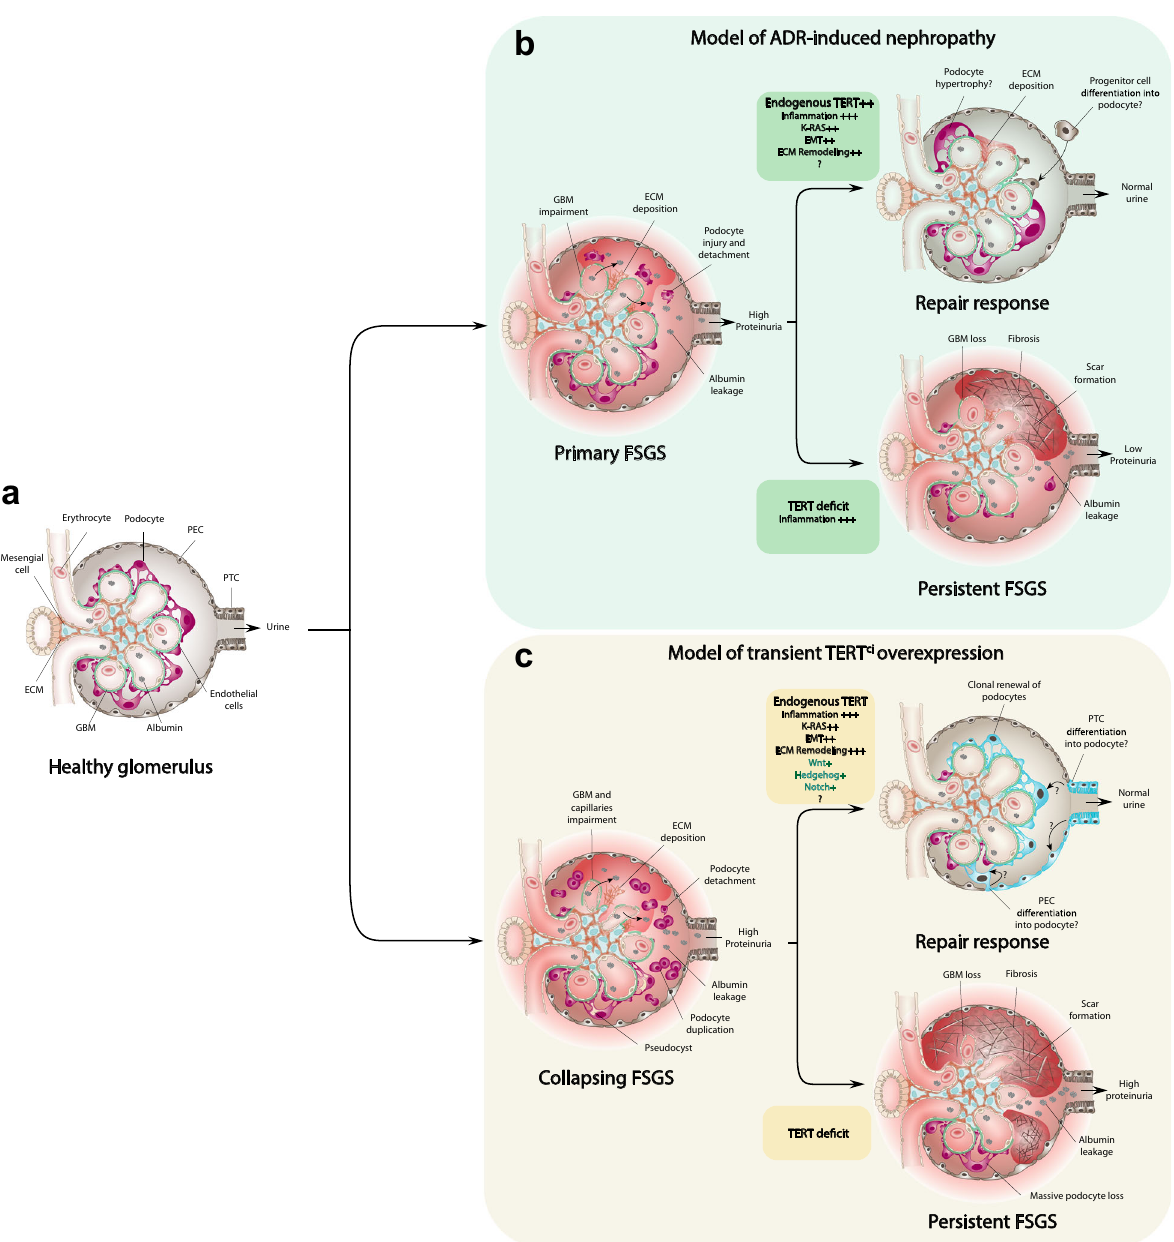
Fig. 8 TERT exhibits non-canonical functions in glomerular repair and podocyte renewal in the adult mouse kidney. Model to illustrate the non-canonical functions of endogenous TERT and TERT ci pulse in glomerular regeneration. a Healthy glomerulus showing terminally differentiated podocytes and intact glomerular basement membrane (GBM). b Following ADR-induced injury, podocytes insult conducts to their detachment from the glomerular capillaries and destabilization of the GBM. Albumin leakage in the urine leads to an increase of proteinuria. Two physiological responses can occur, a repair response that may involve putative podocyte hypertrophy and/or progenitor cell differentiation, or a scar formation that leads to persistent FSGS. Our results suggest that endogenous TERT could mediate the physiological repair via the activation of pro-EMT, ECM-remodeling and KRAS genes, while its de fi cit conducts to its failure. c In a model of ubiquitous and transient transgenic TERT ci overexpression, the dramatic dedifferentiation and proliferation of podocytes conducts to a collapsing FSGS, characterized by the impairment of the GBM and capillary tuft collapse. Our results reveal two scenarios following TERT ci reversal. The repair response is characterized by the expansion of podocyte progenitors that clonally invade the glomerulus to repopulate the PTC, PEC, and podocyte layers which is associated to the modulation of Wnt, Hedgehog, and Notch signaling. This functional repair that conducts to normalization of the proteinuria requires the bi-allelic expression of endogenous TERT. If endogenous TERT is de fi cient, the glomerular repair is not operating, leading to scar formation and persistent FSGS. Focal and segmental glomerulosclerosis (FSGS), Extracellular matrix (ECM), Parietal epithelial cells (PEC), Proximal tubule cell (PTC), Glomerular basement membrane (GBM), Epithelial-to-mesenchymal transition